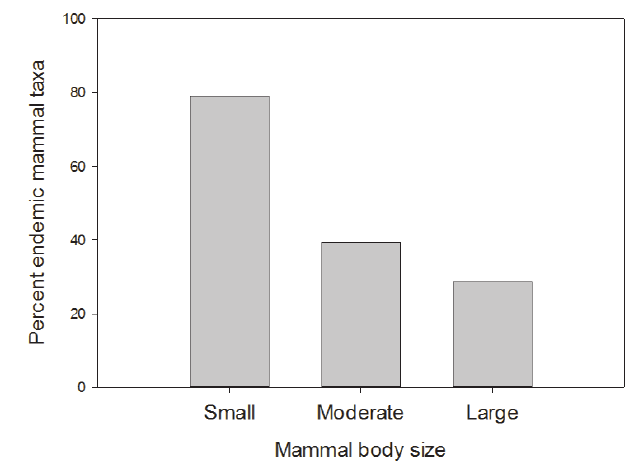
Figure 4: The relation between the prevalence of endemic mammal taxa (subspecies, species and genera) and mammal body